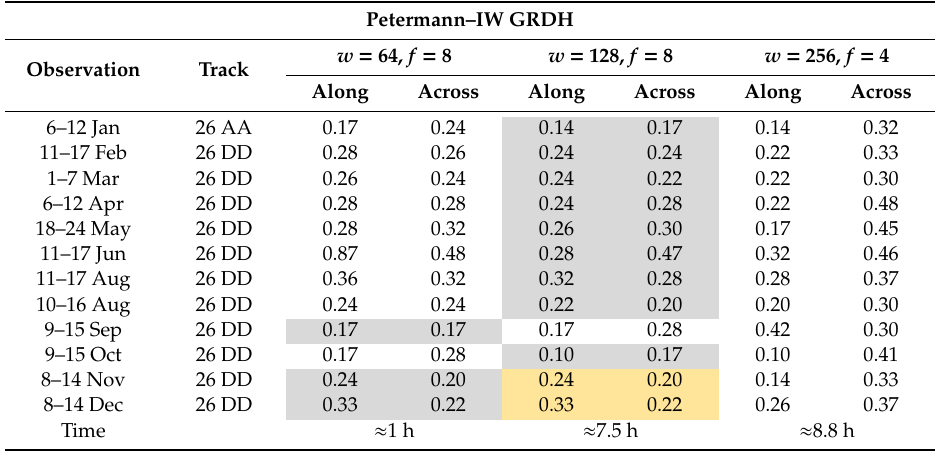
Table 4. PG, IW GRDH product class experiments, RMSE (expressed in m / day) with respect to available literature data measured along selected along flow and across flow transects.